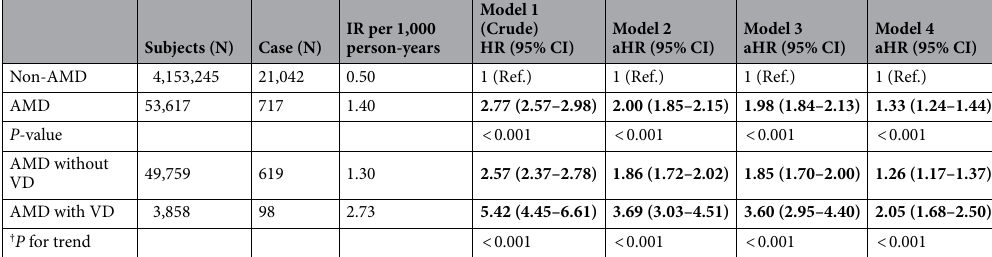
Table 2. Association between AMD and the risk of ESRD according to visual disability. IR incidence rate; PY person-years; HR hazard ratio; aHR adjusted hazard ratio; CI confidence interval. † P for trend was calculated by the (adjusted) hazard ratios among non-AMD, AMD without VD and AMD with VD groups. Model 2: adjusted for age and sex. Model 3: Model 2 + income, area of residence, body mass index, smoking, alcohol consumption, and regular physical activity. Model 4: Model 3 + fasting serum glucose level, serum hemoglobin level, estimated glomerular filtration rate, hypertension, diabetes mellitus, dyslipidemia, and Charlson comorbidity index. Significant values are in bold.